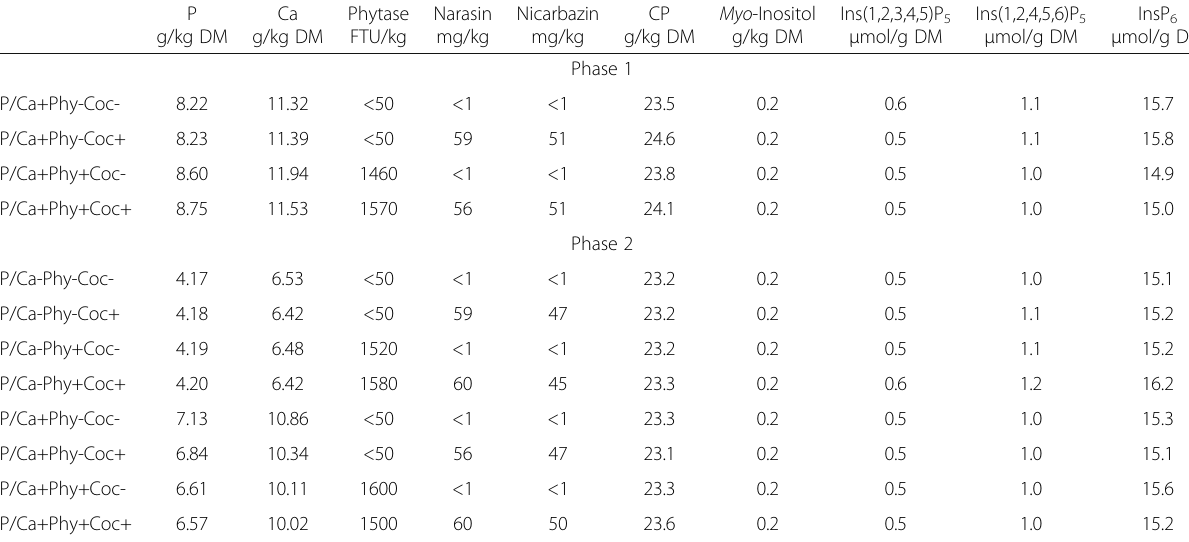
Table 5 Analyzed composition of the experimental diets P g/kg